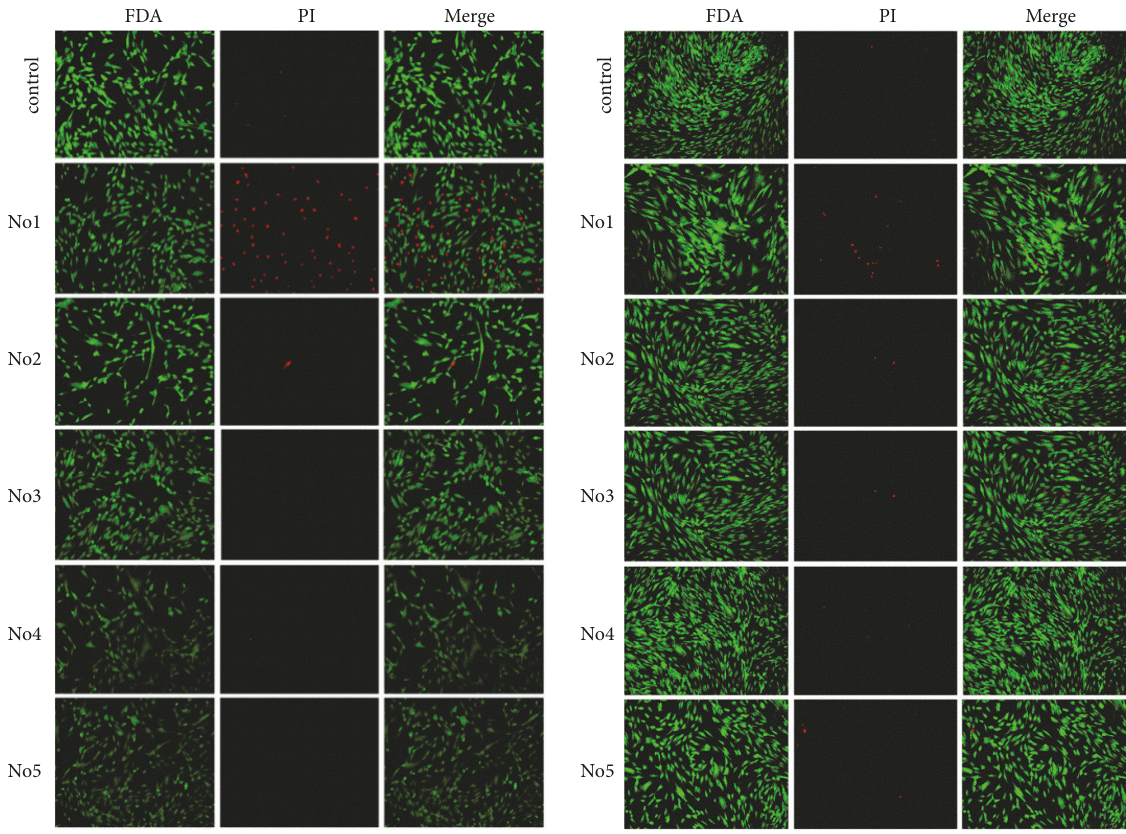
Figure 3: ADSCs in control and experimental media in 24h (left panel) and 72h (right panel) in culture. Deuterium concentration: control: D/H 150 ppm; No. 1: D/H 500.000ppm; No. 2: D/H 100.000ppm; No. 3: D/H 10.000ppm; No. 4: D/H 75 ppm; No. 5: D/H 15 ppm. Fluorescent microscopy. FDA/PI